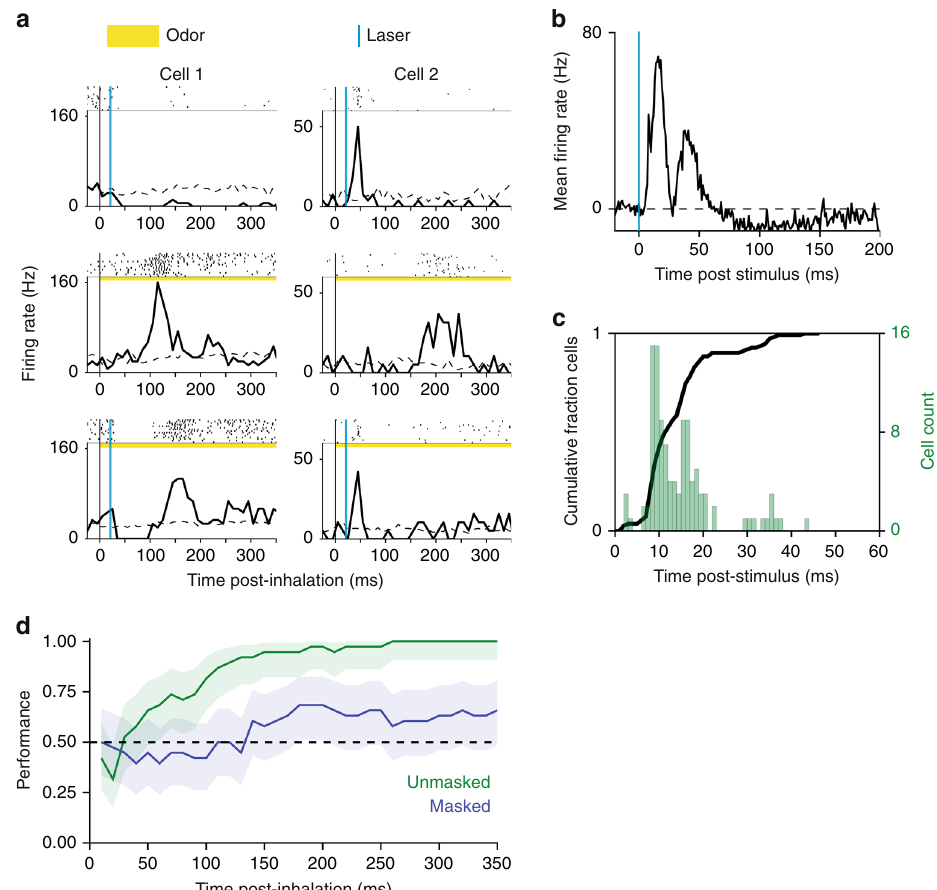
Fig. 2 Neural response to optogenetic mask and effect on odor information. a Example raster and PSTH for two example MT cells. Inhalation onset corresponds to t = 0. Top: Example MT cell responses to optogenetic mask (25 mW, ON:2 ms — OFF:8 ms — ON:2 ms), light stimulation at 20 ms post- inhalation onset. Middle: Odor response (left: 2-hydroxyacetophenone, right: alpha-pinene). Bottom: Odor plus laser mask. b Baseline-subtracted mean of PSTHs for laser-responsive units ( n = 113). c Cumulative distribution function (black line) and histogram of units ’ response latencies to masking light stimulus. d Linear classi fi er cross-validation results for unmasked data for two odor presentations (limonene, pinene). Responses to unmasked odor presentations were time-binned (10 ms bins) and used to train support vector machine (SVM) classi fi ers. For each time point, SVMs were trained using the response vector inclusive of bins from t = 0 to that time. Each classi fi er ’ s performance is described by cross-validation on unmasked trials (blue) and testing on masked trials (green). Shaded areas indicate 95% con fi dence interval (Clopper – Pearson